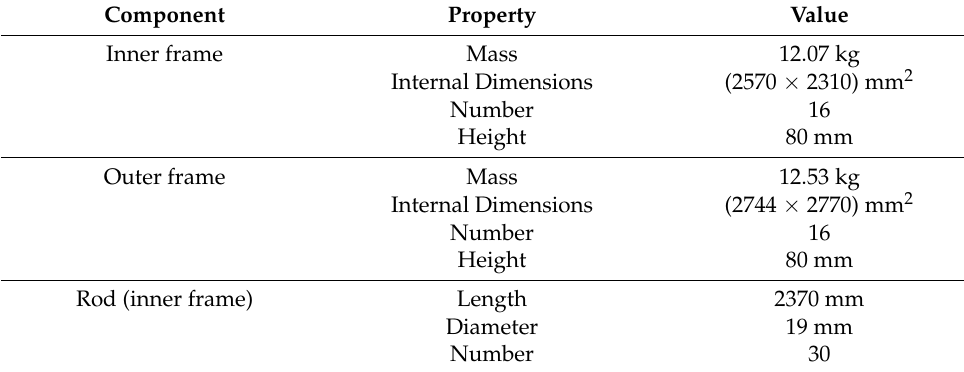
Table 3. Components of the laminar shear box.